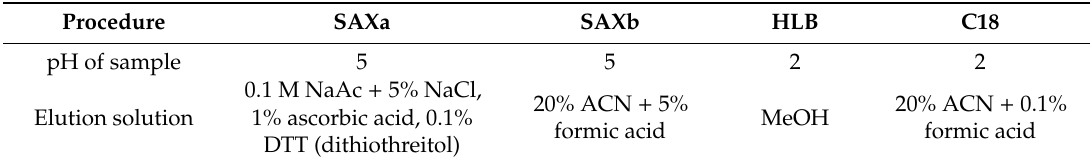
Table 2. Overview of di ff erent purification procedures by solid phase extraction applied during our studies.